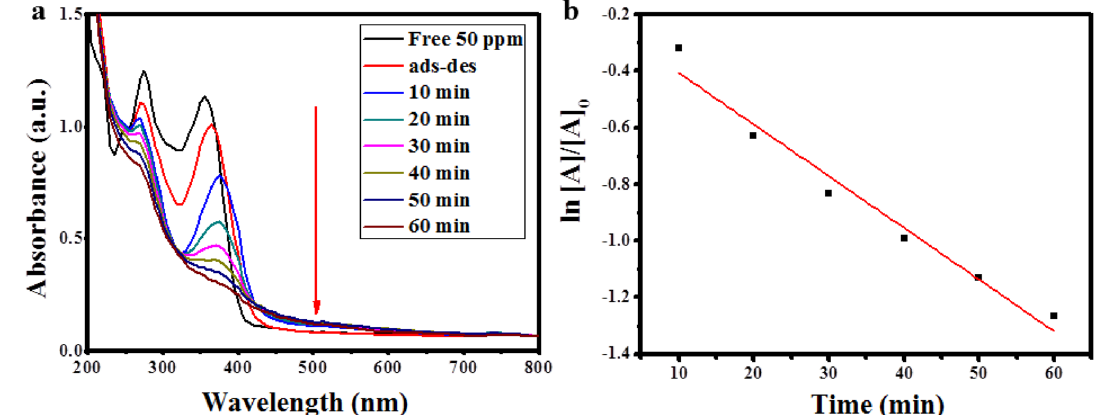
Figure 11. UV–Vis absorption spectrum for the photodegradation of TC by Ag/ZnO@BC under the optimum conditions (TC concentration 50 ppm, pH 6, dose of Ag/ZnO@BC 0.01 g, temperature of 25 °C, and H 2 O 2 concentration of 100 mM) ( a ) Kinetics of photocatalytic degradation of TC under the optimum conditions ( b